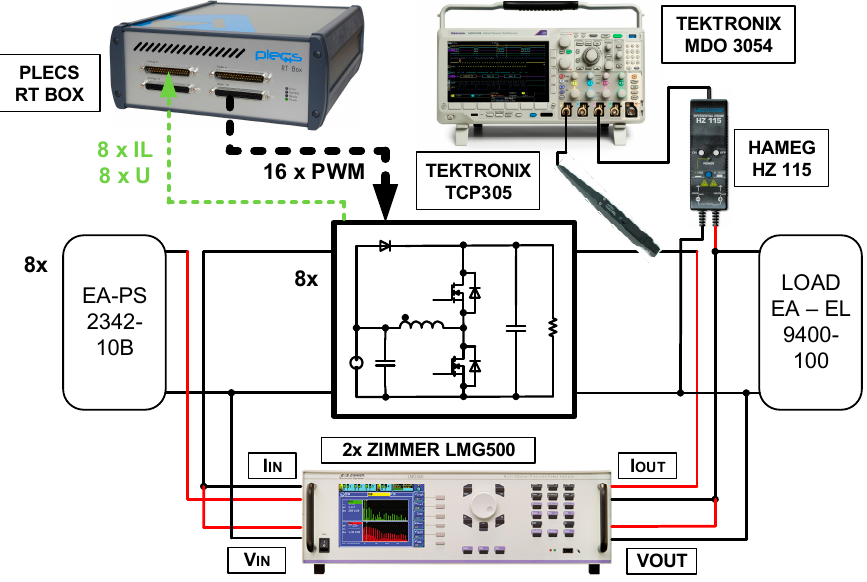
Figure 13. Preview of laboratory equipment and experimental set-up during measurements.